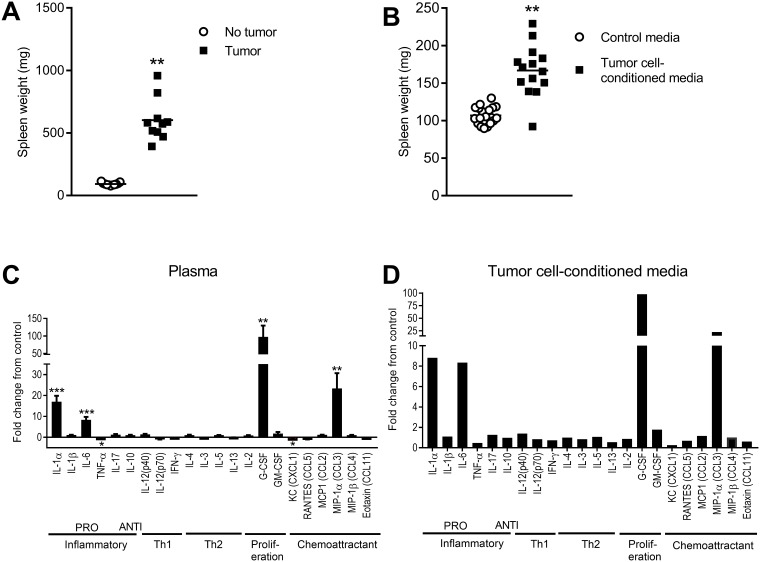
Tumor-bearing mice show evidence of inflammation.A Spleen weights (mean ± SE) of non-tumor mice (n = 12) and tumor-bearing mice (n = 10) after 24 days of tumor growth. B Spleen weights (mean ± SE) for mice treated with control medium (n = 19) versus mice treated with 4T1.2 tumor cell-conditioned medium (n = 14). C Cytokine and chemokine profile of plasma of tumor-bearing mice (n = 10–11) (mean ± SE). Fold change relative to non-tumor mice. D Cytokine and chemokine profile of 4T1.2 tumor cell-conditioned medium. Fold change relative to control medium. **p < 0.01.